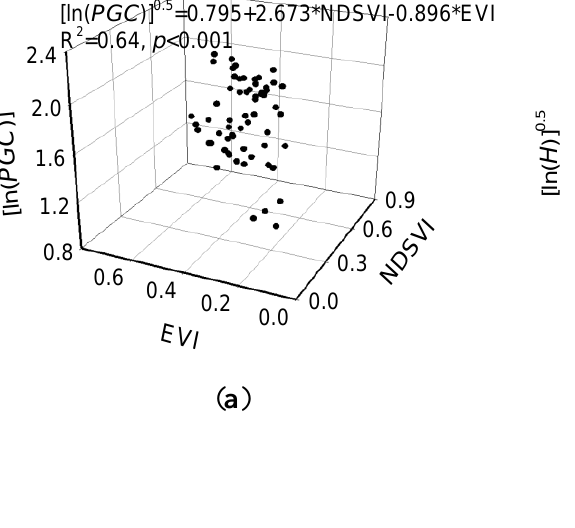
Figure 3. The relationships between transformed canopy features and selected spectral drivers for ( a ) PGC (%); ( b ) H (cm); ( c ) GBM (g∙m −2 ); and ( d ) TBM (g∙m −2 ) in Inner Mongolia. The driving factors were selected with stepwise linear regression with p <